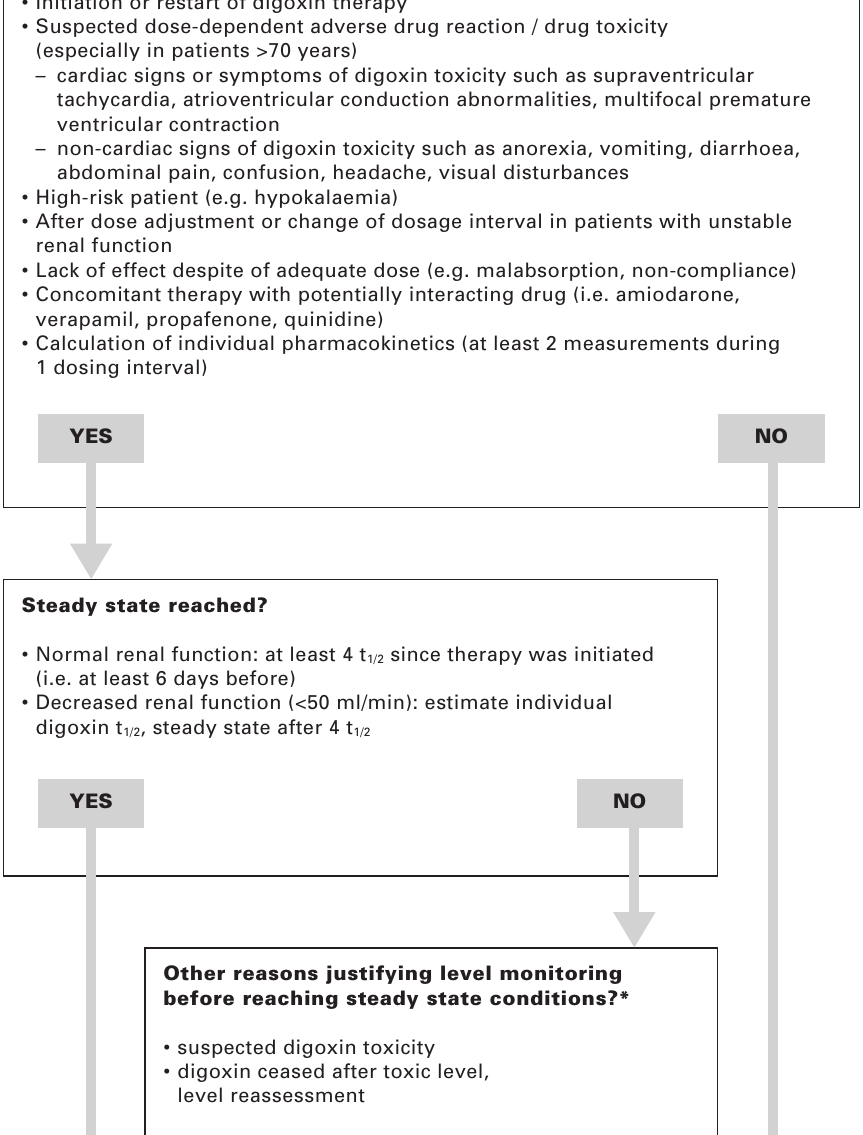
Appropriate indication for digoxin level Algorithm for digoxin level monitoring (for further explanations see Appendix 1).